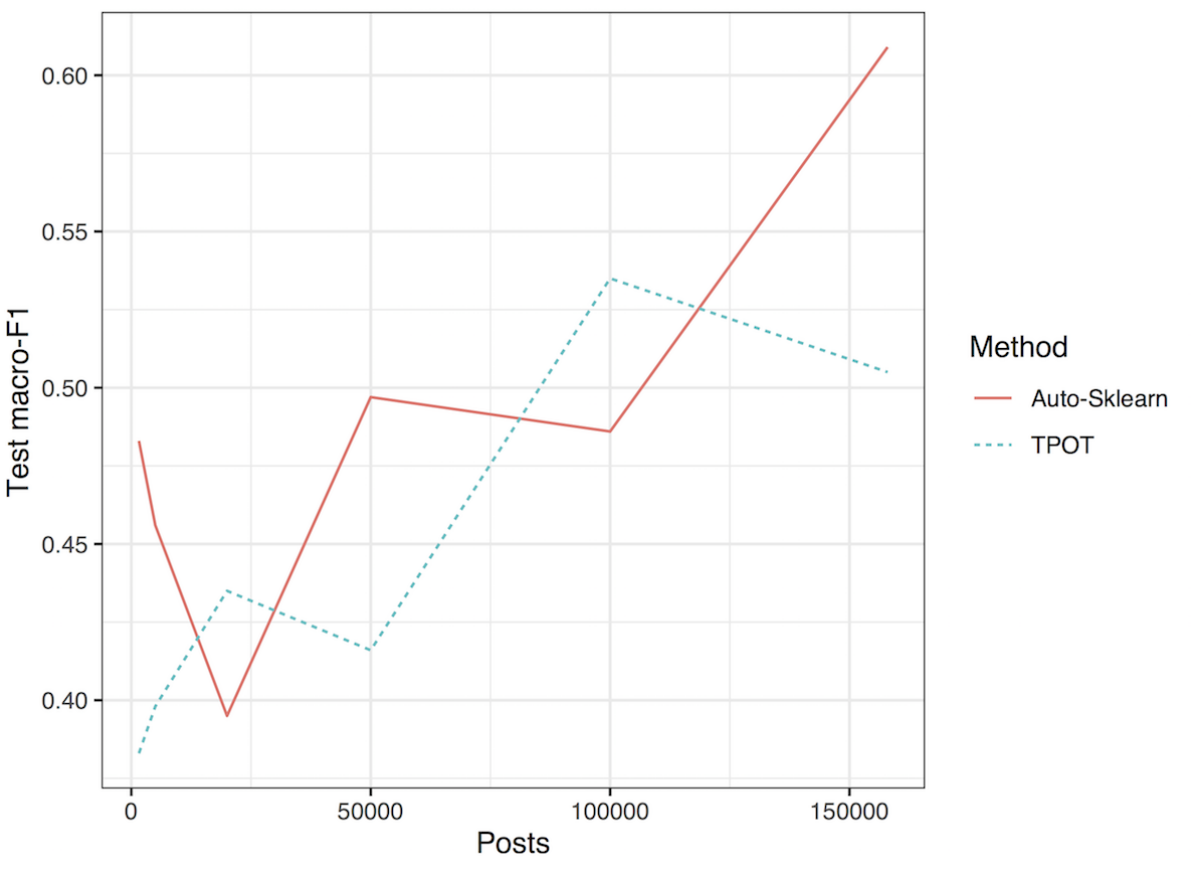
Figure 2. A graph of macro-F1 test scores versus the number of posts used for Generative Pretrained Transformer-1 fine-tuning. Auto-Sklearn methods are marked with continuous red (Auto-Sklearn) and dashed blue (Tree-based Optimization Tool, TPOT)